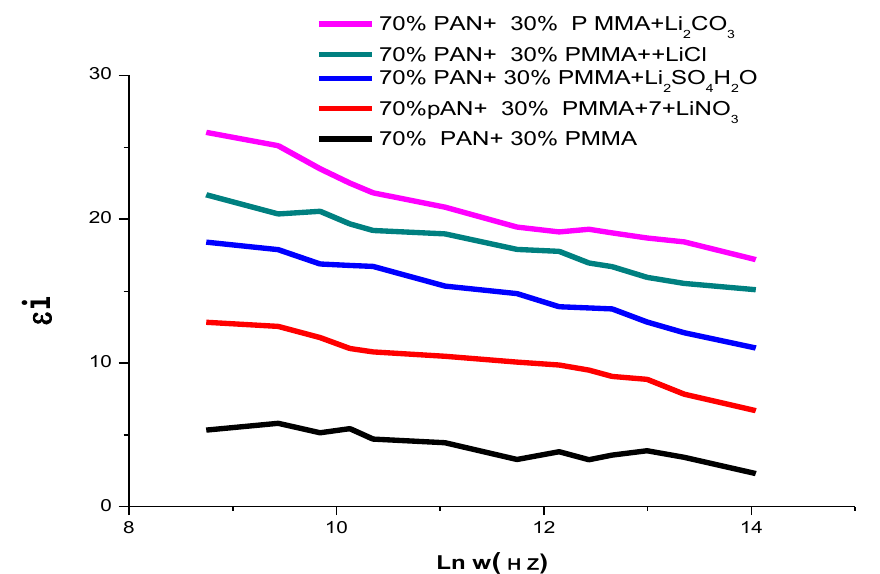
Figure 3c: The imaginary dielectric constant as function of ln (ω) of undoped (70%PAN+30%PMMA) and doped with 20% (Li